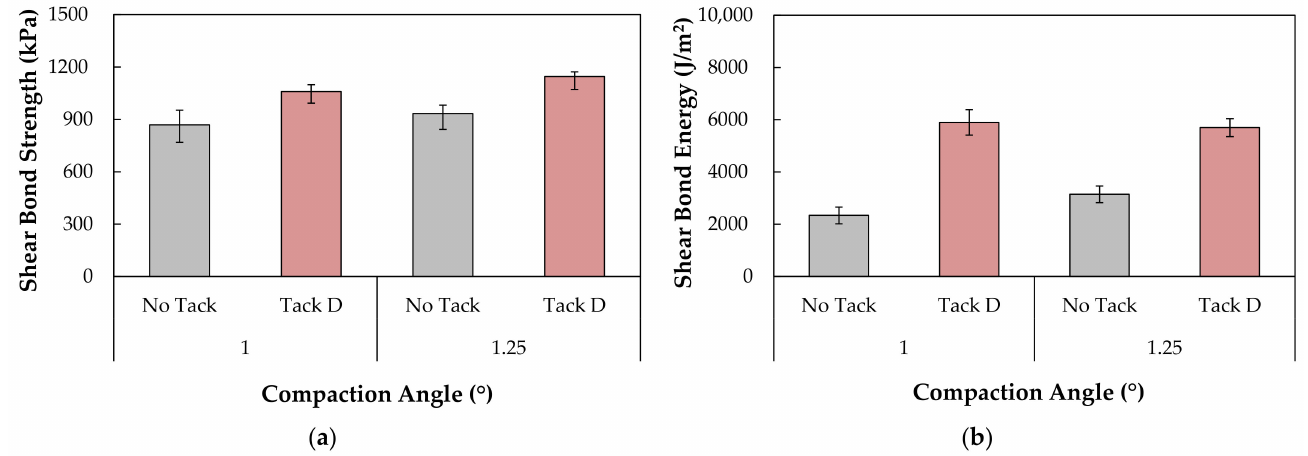
Figure 10. Effect of compaction angle on ( a ) shear bond strength and ( b ) shear bond